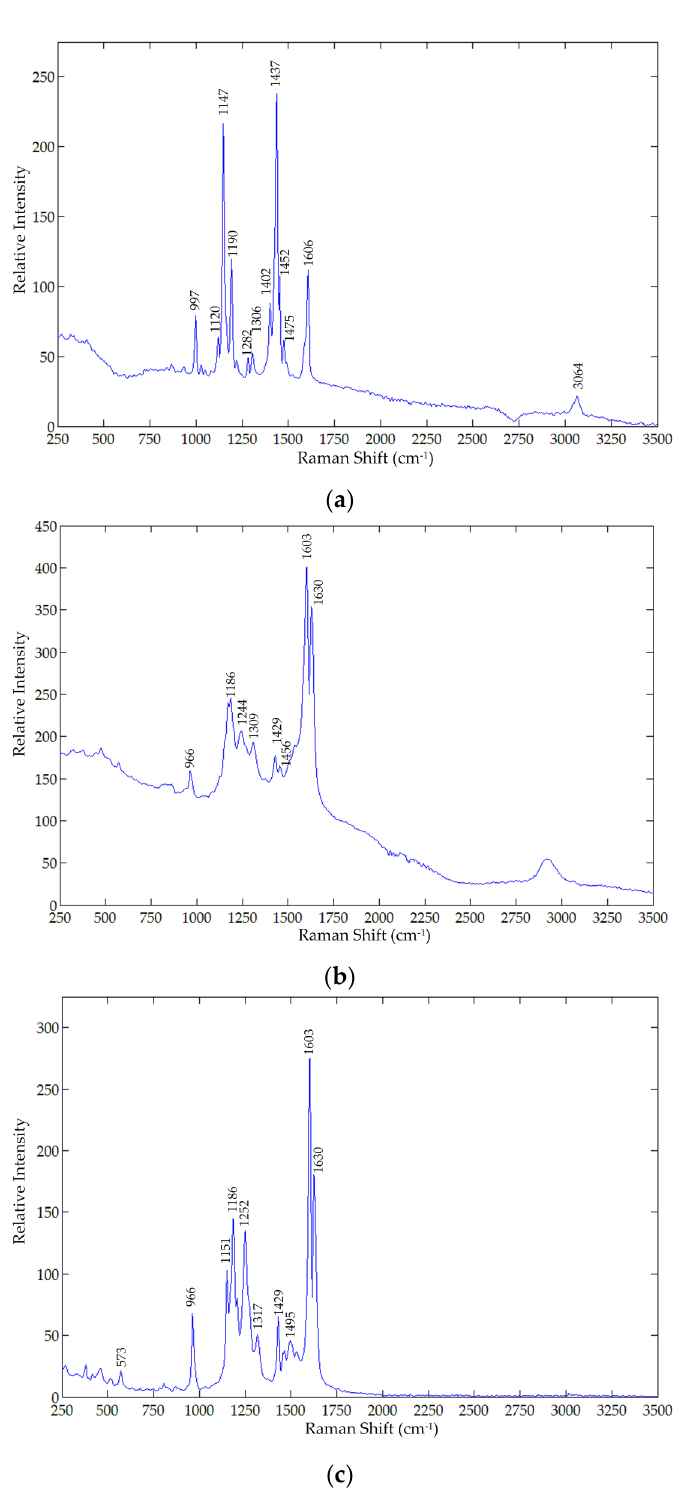
Figure 2. FT-Raman spectra of: ( a ) Metanil yellow; ( b ) Turmeric powder; ( c )